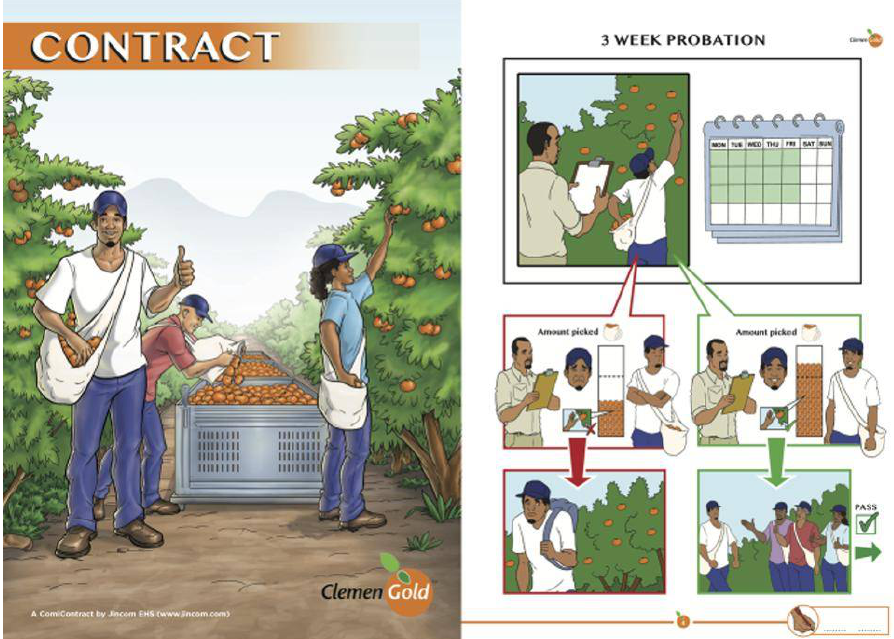
Figure 6. Work contract drafted in comics form by Comics Contracts and Jincom Publishing, South